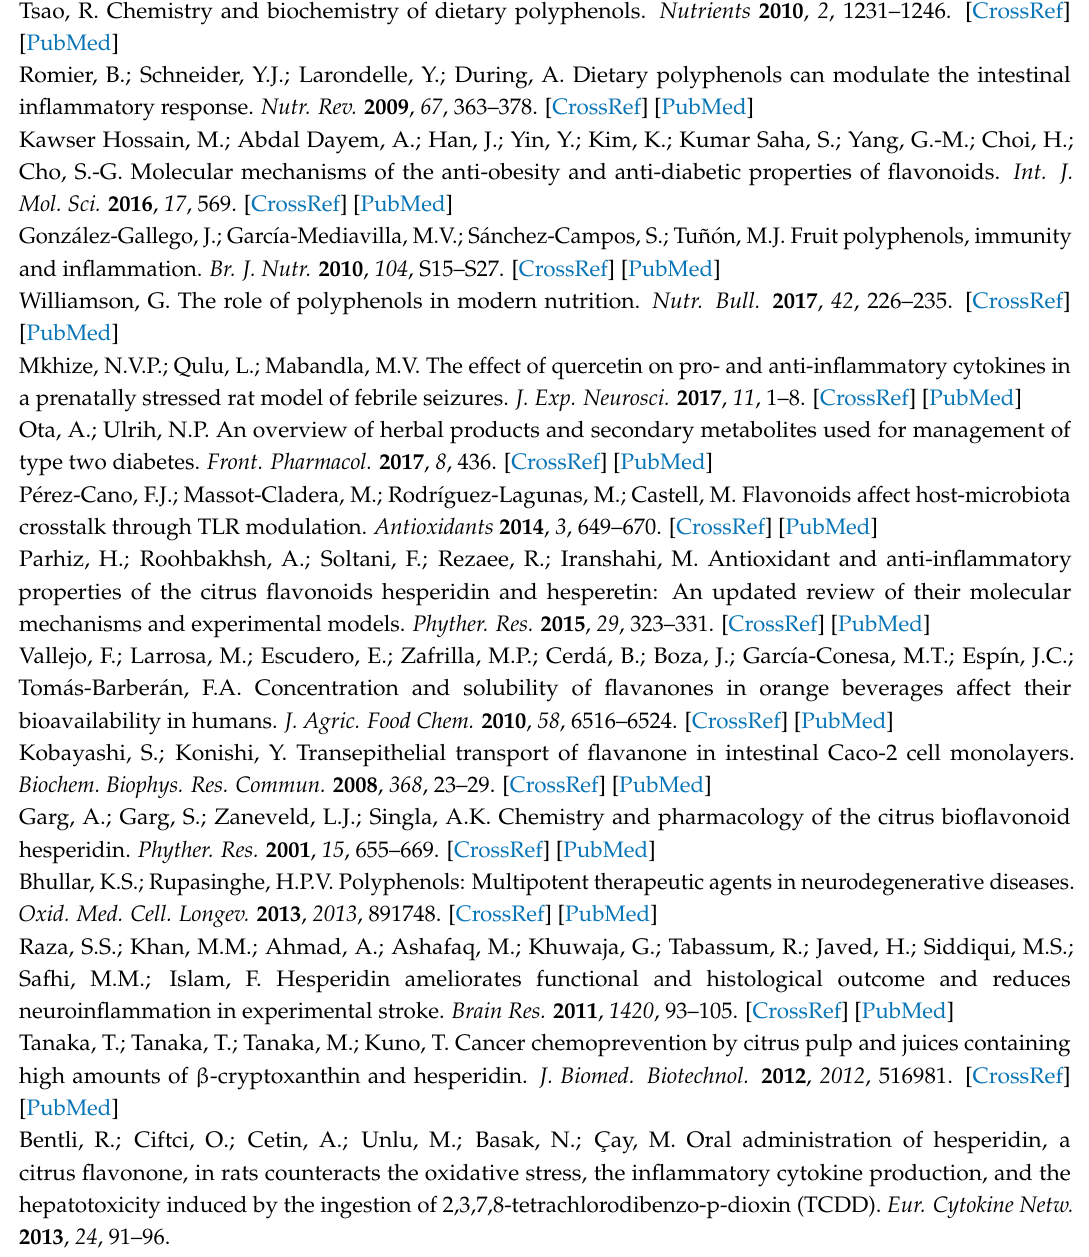
caecal homogenates, Table S1: Composition of the diet (Teklad Global 14% Protein Rodent Maintenance Diet, Madison,